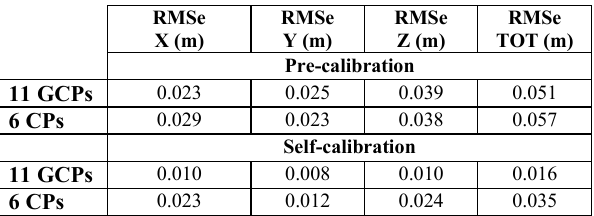
Table 2 RMSe on GCPs and CPs for standard processing of Dataset A adopting pre-calibration and self-calibration approaches.